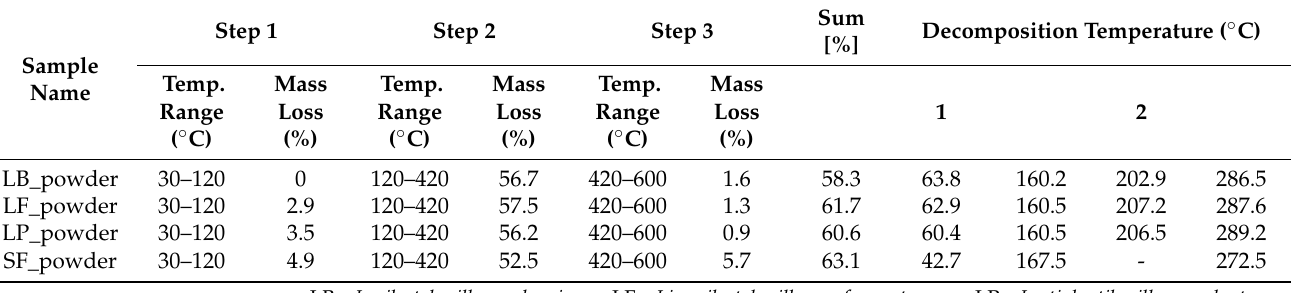
Table 4. TGA—thermal decomposition of